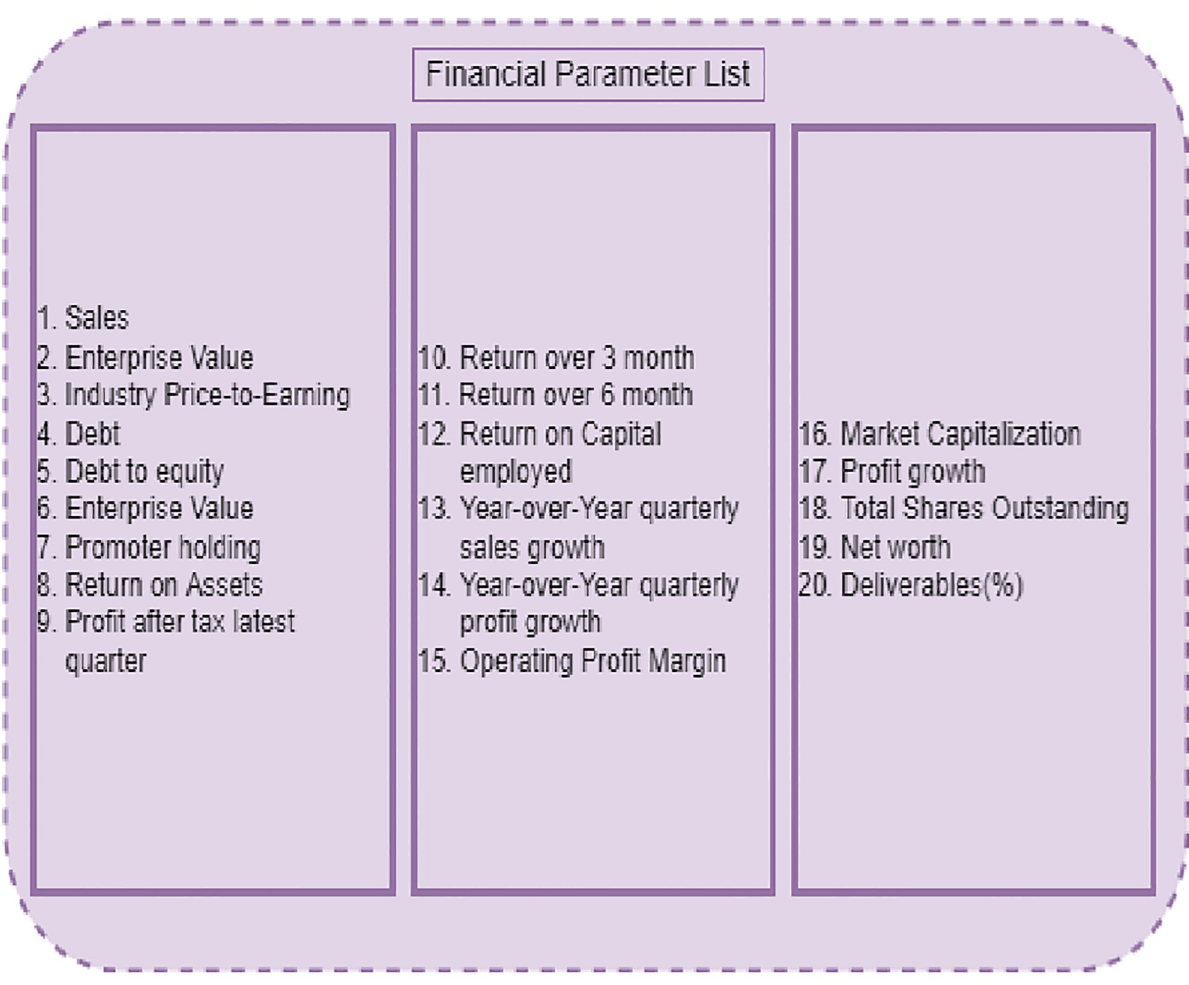
Fig 5. BorutaPy feature selection algorithm based final selected